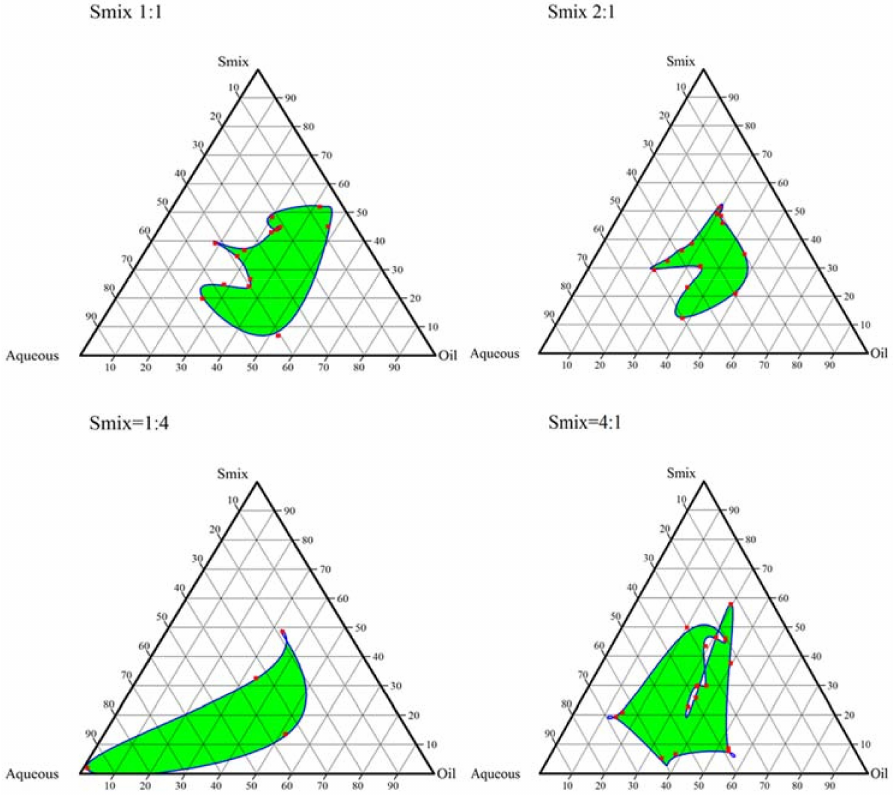
Figure 1. Ternary plots for nanoemulsions obtained using cinnamon oil, tween 80 and ethylene